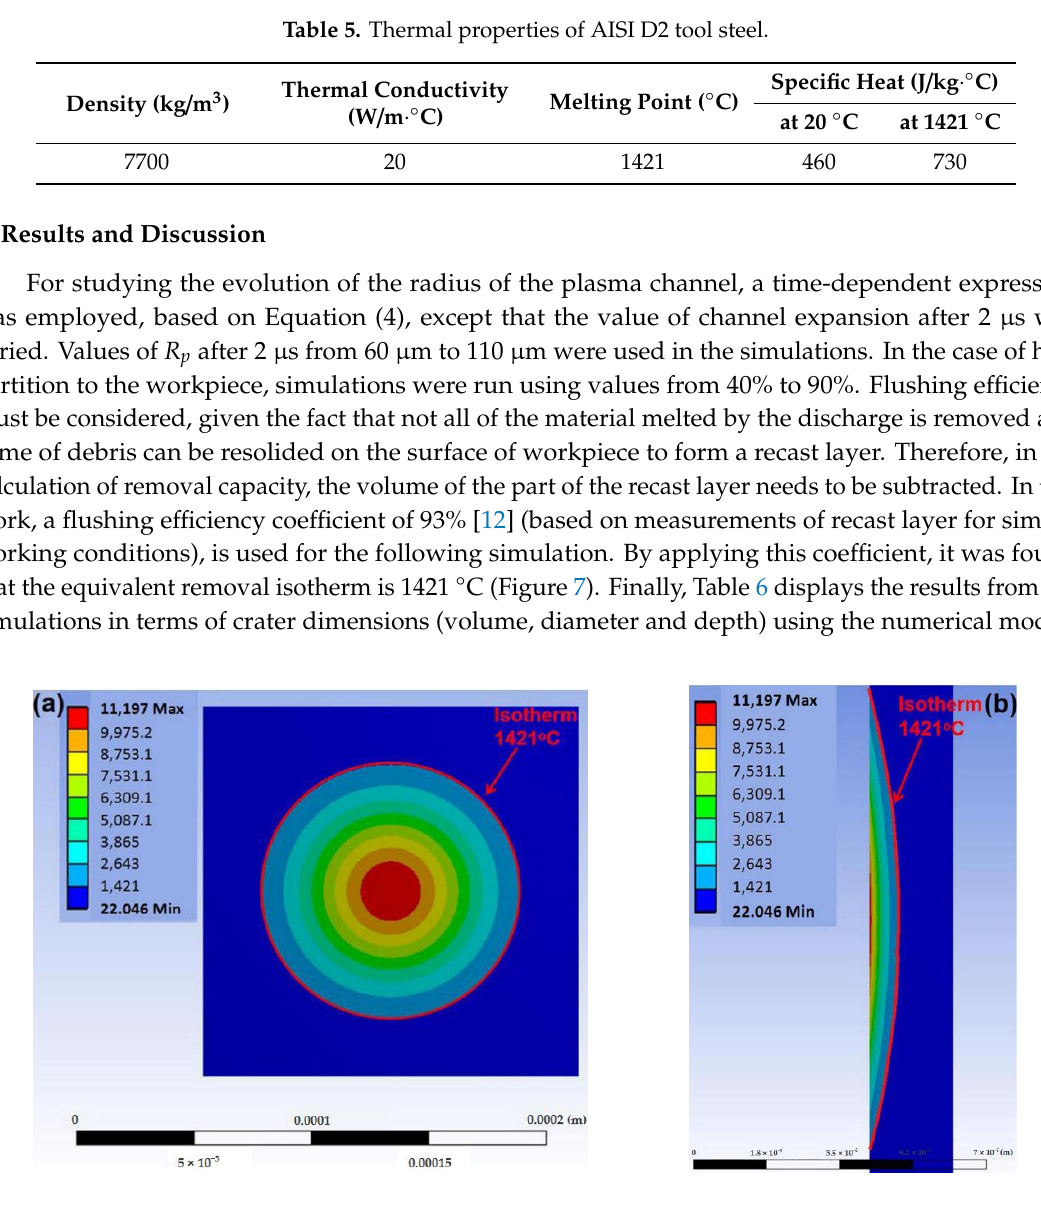
Figure 7. One of the simulation results of the thermal modeling of the crater: ( a ) Front view and ( b ) lateral view. Table 6. Crater dimensions from numerical simulation of different combinations of heat partition to the workpiece ( f c ) and radius of the plasma channel after 2 µs.